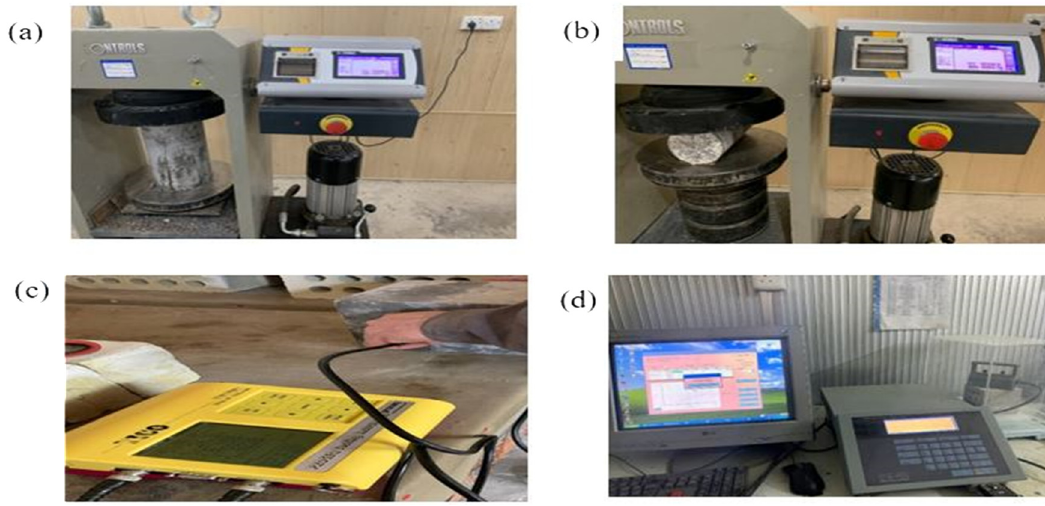
Figure 2: Experimental tests of specimens: ( a ) compressive strength, ( b ) splitting tensile strength, ( c ) ultrasonic pulse velocity, and ( d ) thermal conductivity.